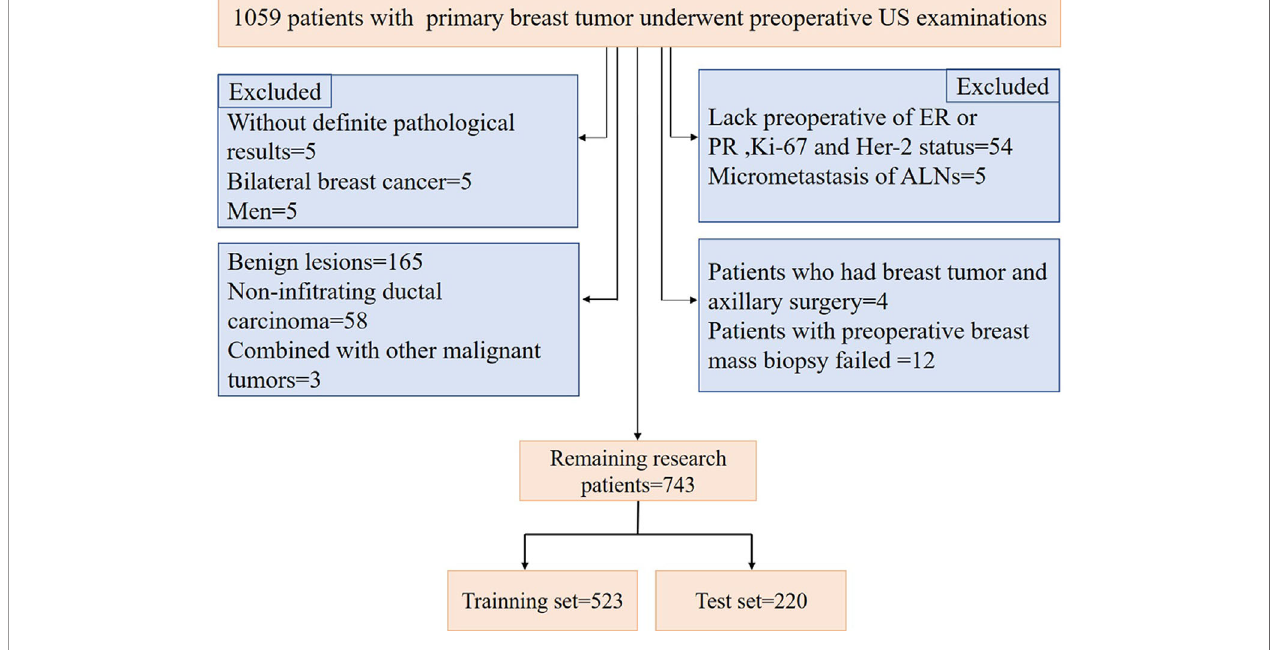
FIGURE 1 | Recruitment process for study